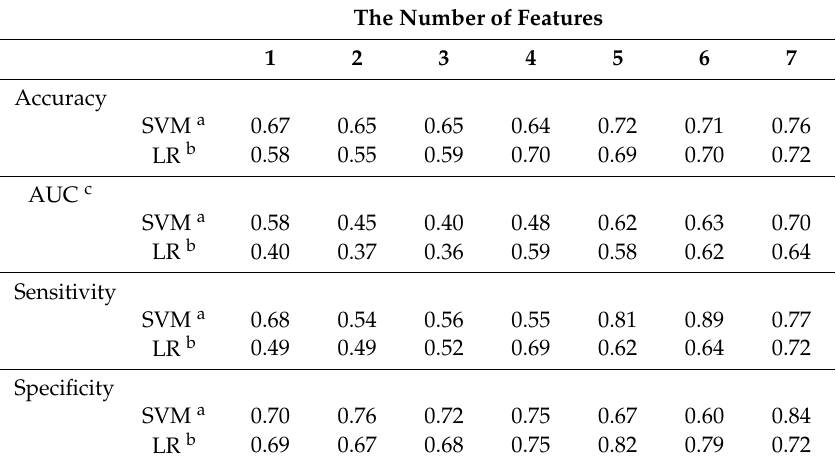
Table 3. Classification results of SVM a and LR b from the training set.